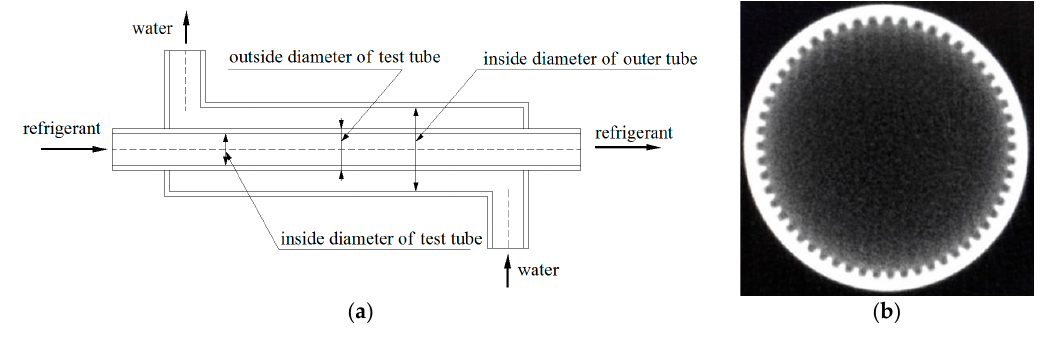
Figure 2. ( a ) The test section and ( b ) cross-sectional view of the micro-fin tube. Table 1. The structural parameters of test